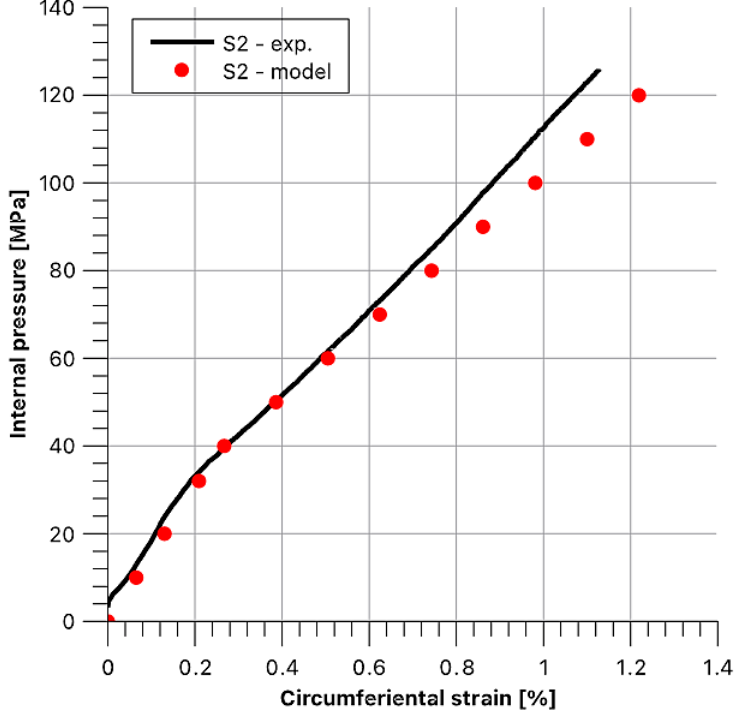
Figure 21. Stress and strain results as a function of internal pressure for sample S2.